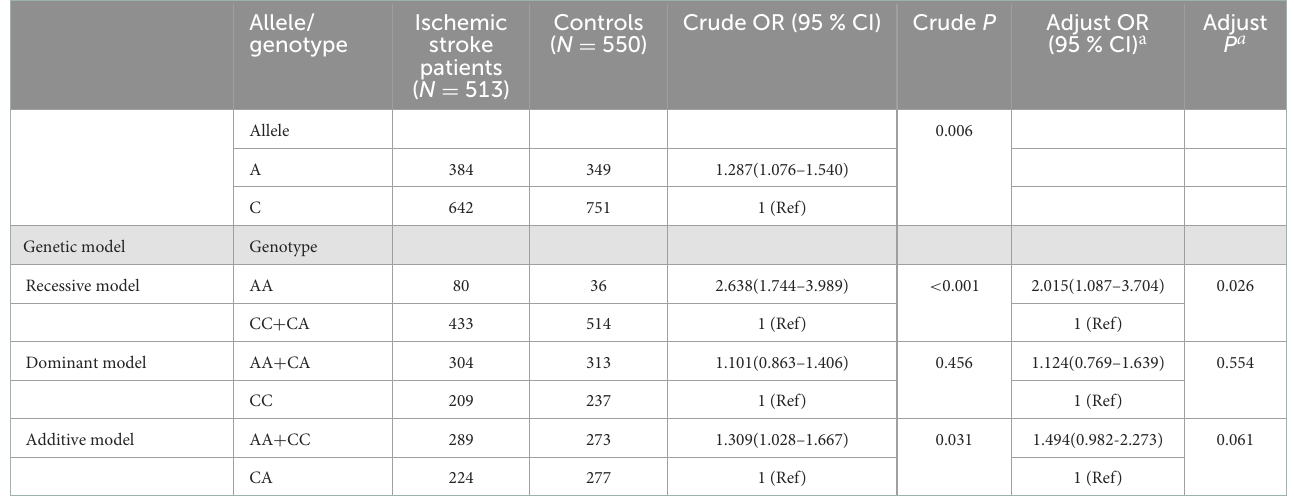
TABLE 2 Association between ERCC1 rs3212986 polymorphism and ischemic stroke susceptibility. Allele/